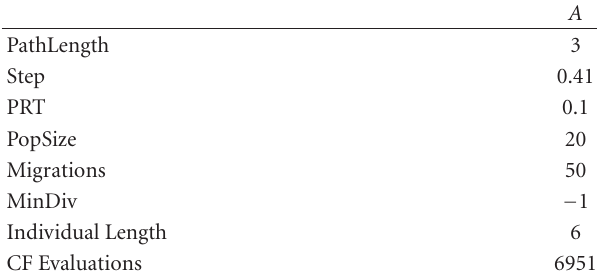
Table 1: SOMA parameter